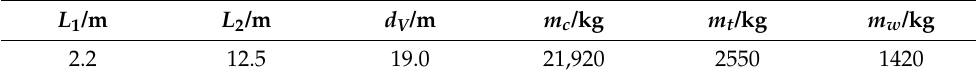
Table 2. Vehicle parameters [27].